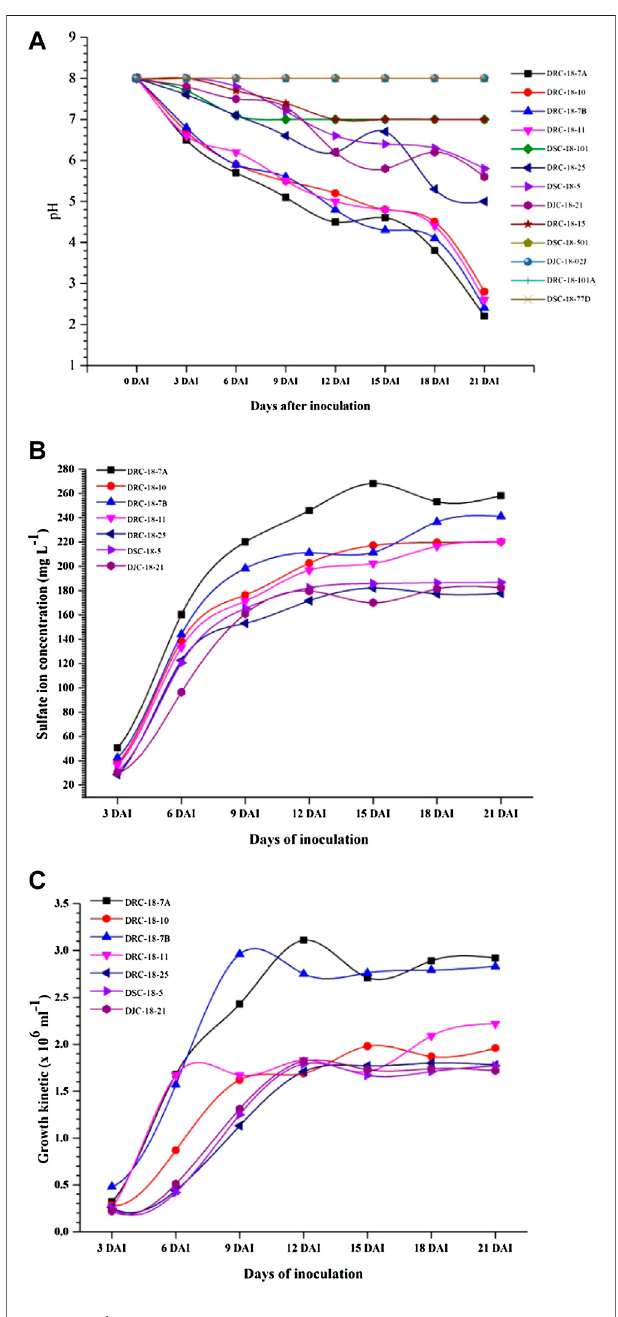
FIGURE 3 | Characterization of sulfur-oxidizing bacterial isolates for (A) pH reduction, (B) sulfate ion production, and (C) growth kinetics under controlled laboratory